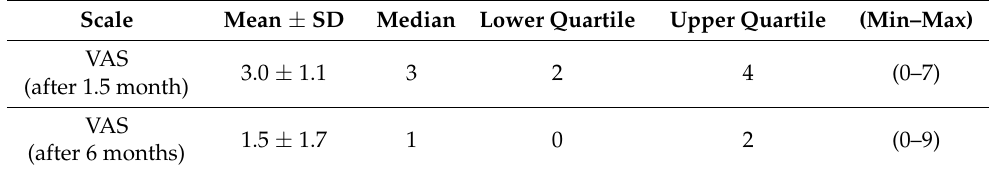
Analysis of the degree of pain experienced by patients after hip arthroplasty at defined intervals.